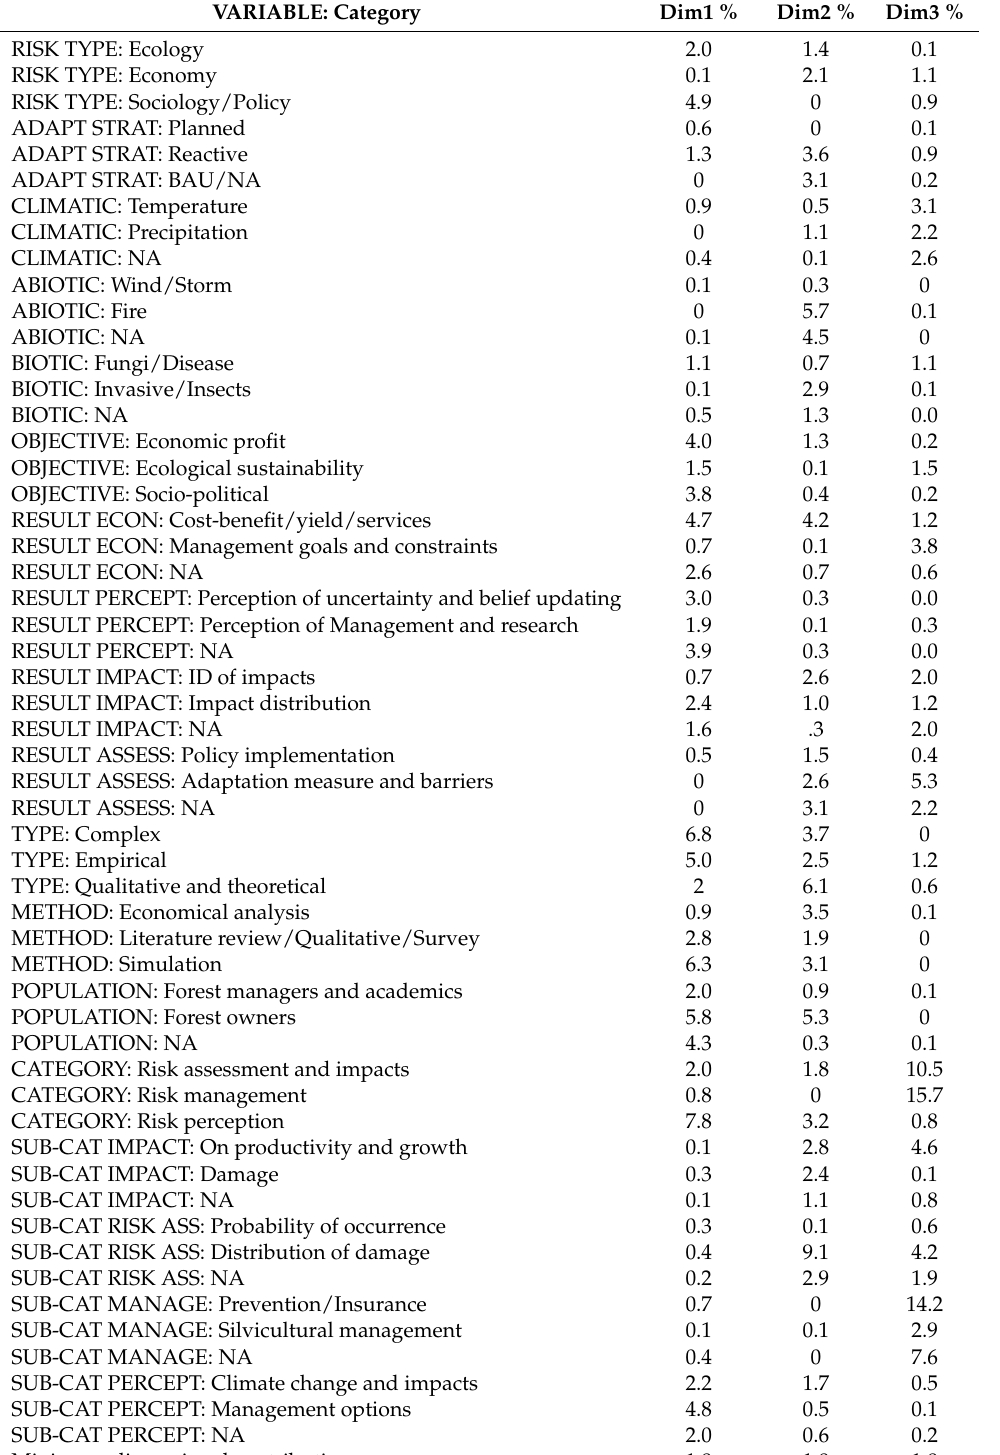
Table A2. % of explained variance in our MCA for our chosen combinations of variables and modalities and the mean explained variance of each